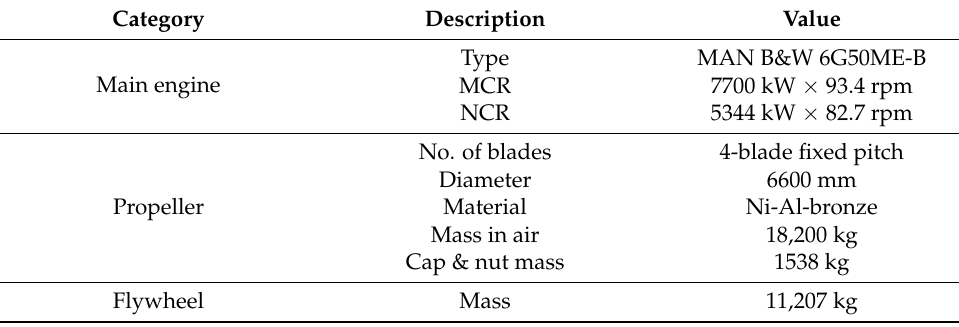
Table 2. Specifications of shaft system of target ship.